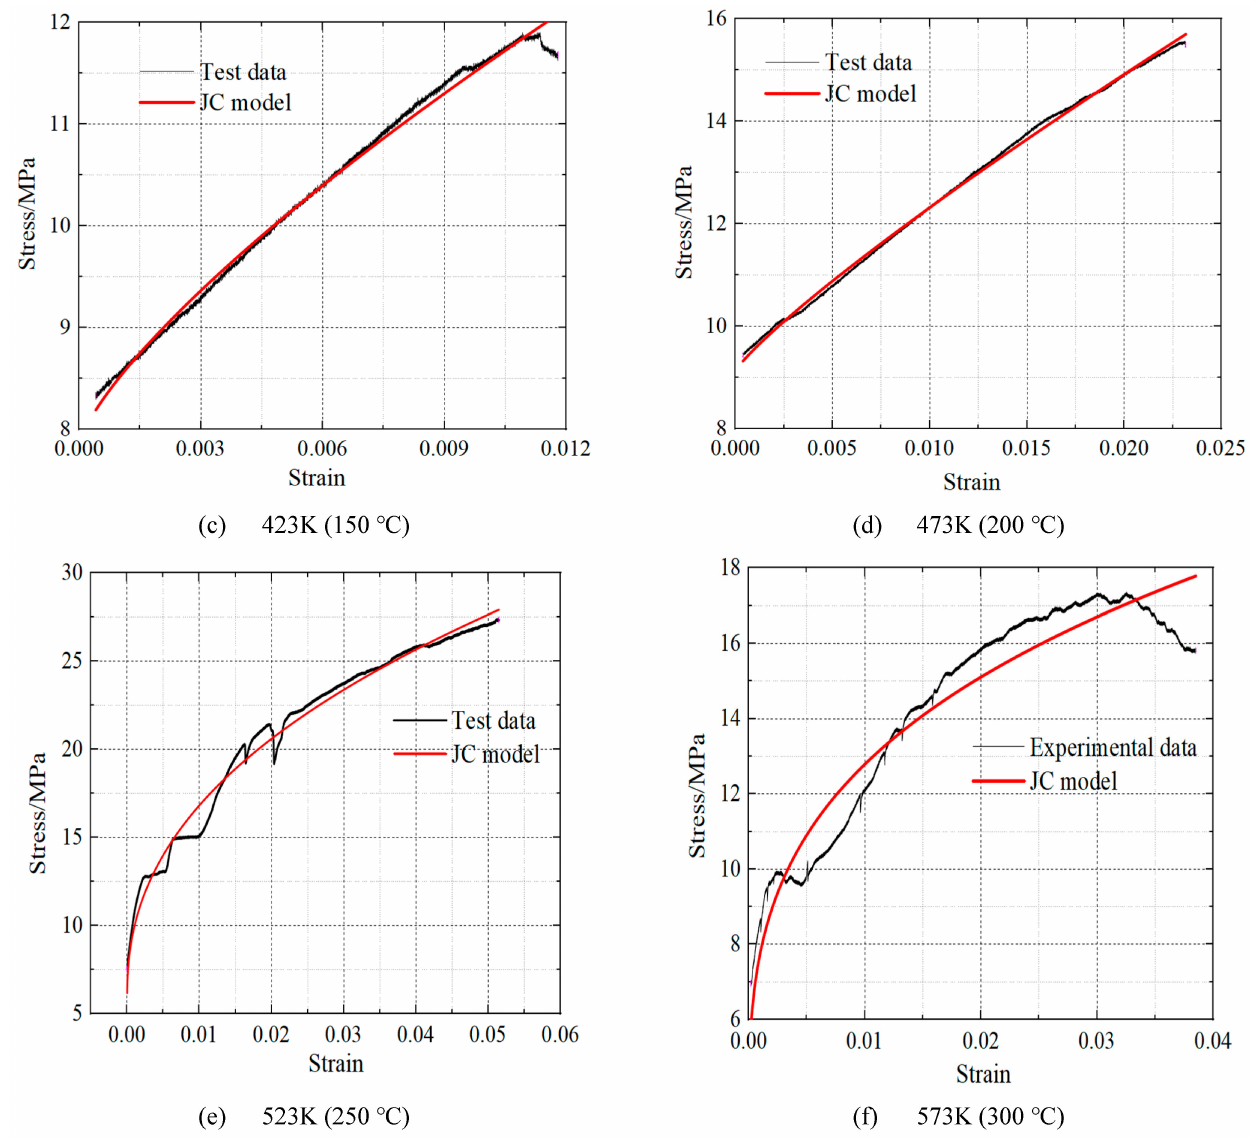
Figure 9. Comparison between test data and simulated data by the Johnson − Cook constitutive model at various high